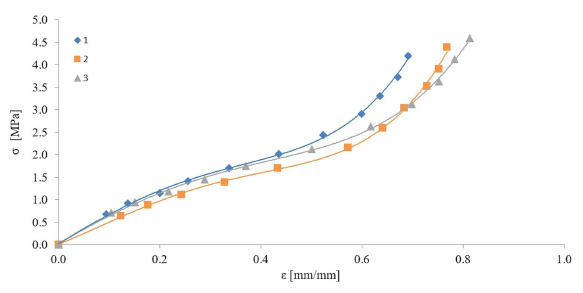
Figure 8: The deflection of the rubber samples under increasing pressure.